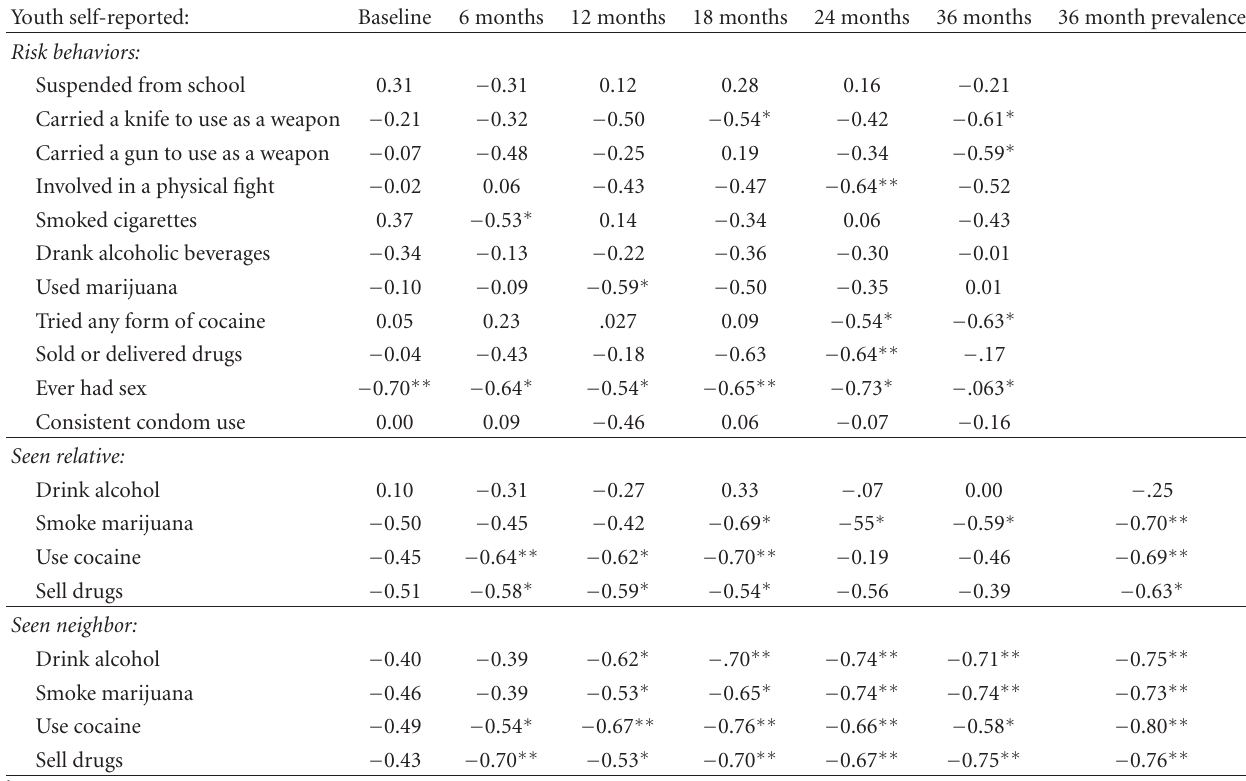
Table 4: Standardized regression coe ffi cients for GLAT scores 1 predicting youth reported behavior over the past 6 months. Youth